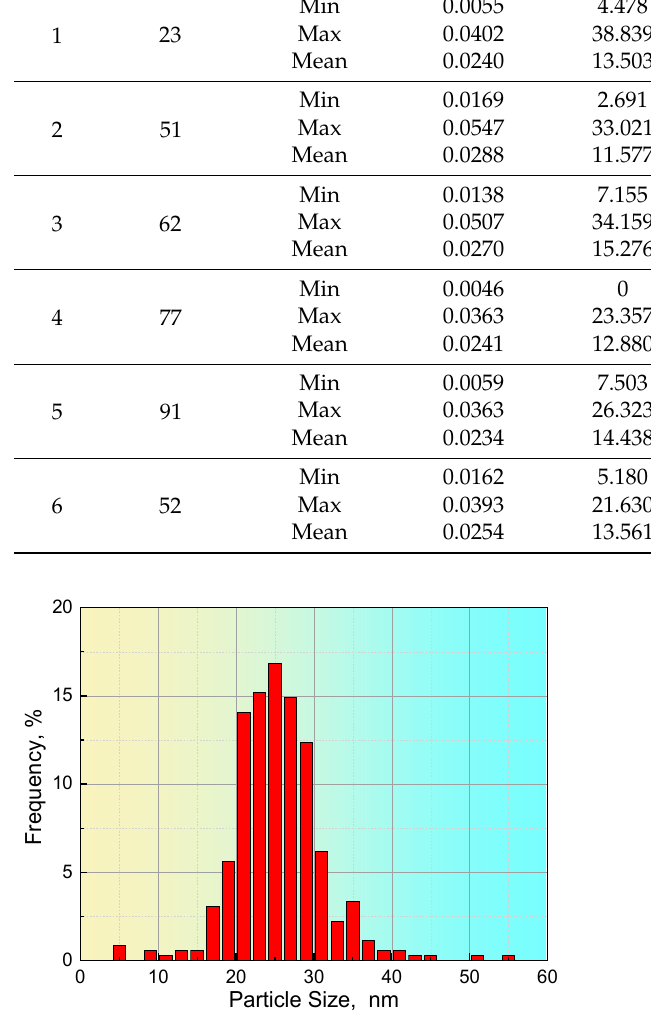
Figure 7. Distribution of the size of the precipitates in steel S2.